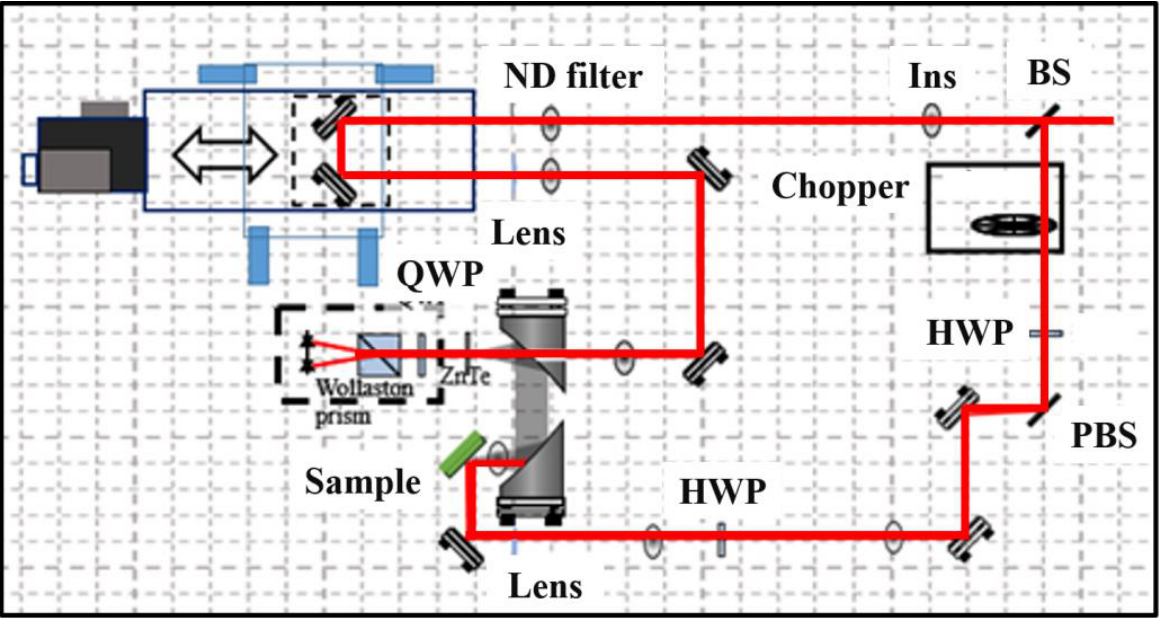
Figure 1. A transmission type THz emission setup (all abbreviations are explained in the text).